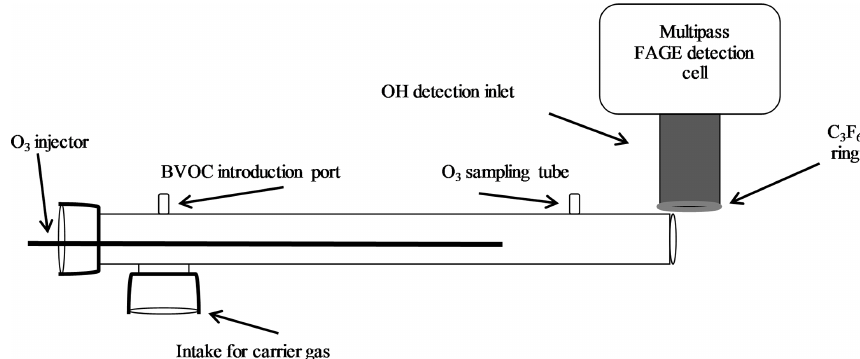
Figure 1. Schematic of the atmospheric pressure flow system used in this study.